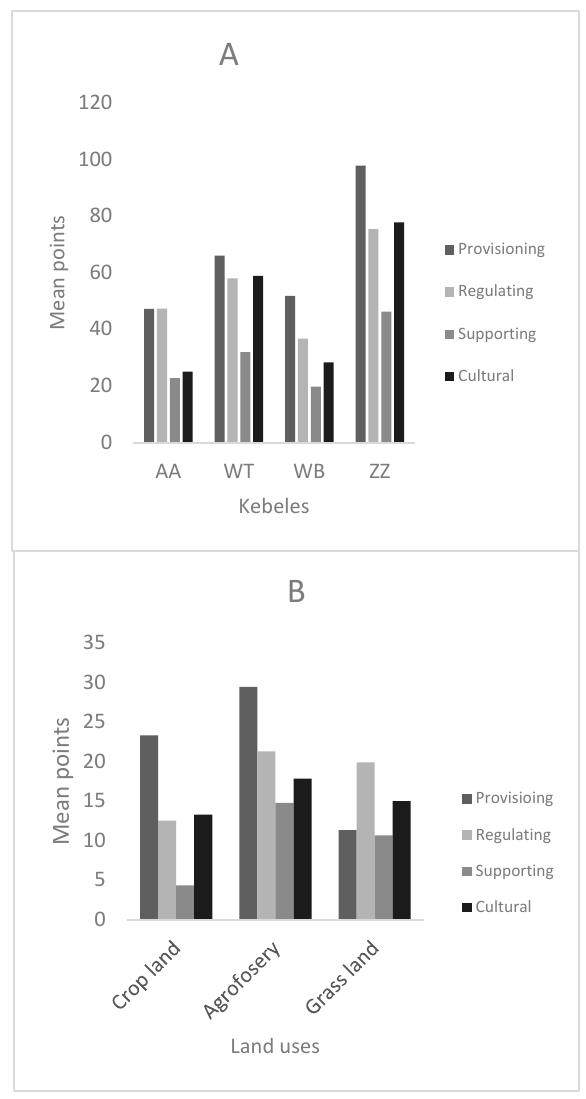
Figure 3. Comparisons of relative potentials (mean points) of ecosystem service categories by ( A ) kebeles and ( B ) land uses; AA-Addis Alem kebele , ZZ-Zenzelima kebele , WT-Weramit kebele and WB-Wereb kebele .